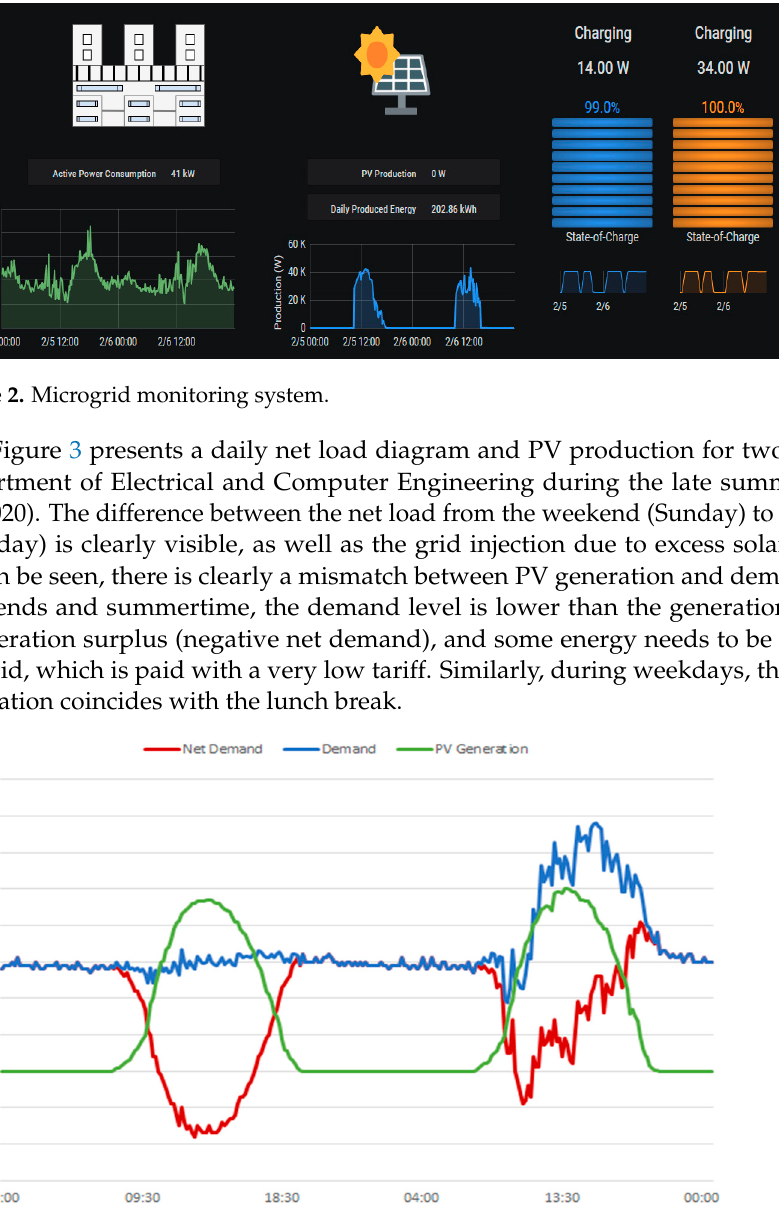
Figure 3. Net Demand, Demand and PV Generation in the DEEC Building for 2 days (From Sunday to Monday, 6–7 September).